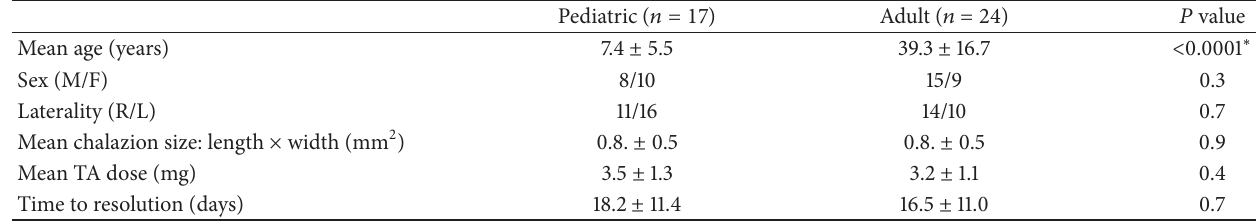
Table 1: Differences in baseline and outcome in children versus adults.